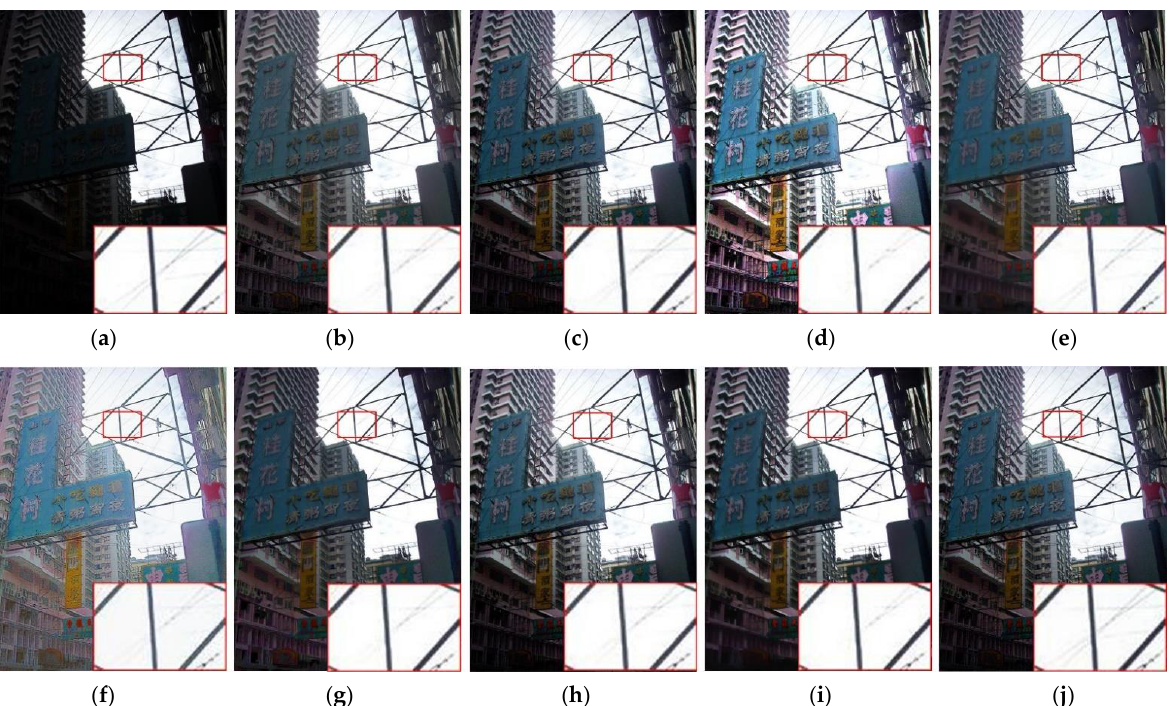
Figure 19. Enhanced results of “Street” image. ( a ) Original image; ( b ) BIMEF; ( c ) MEF; ( d ) LIME; ( e )